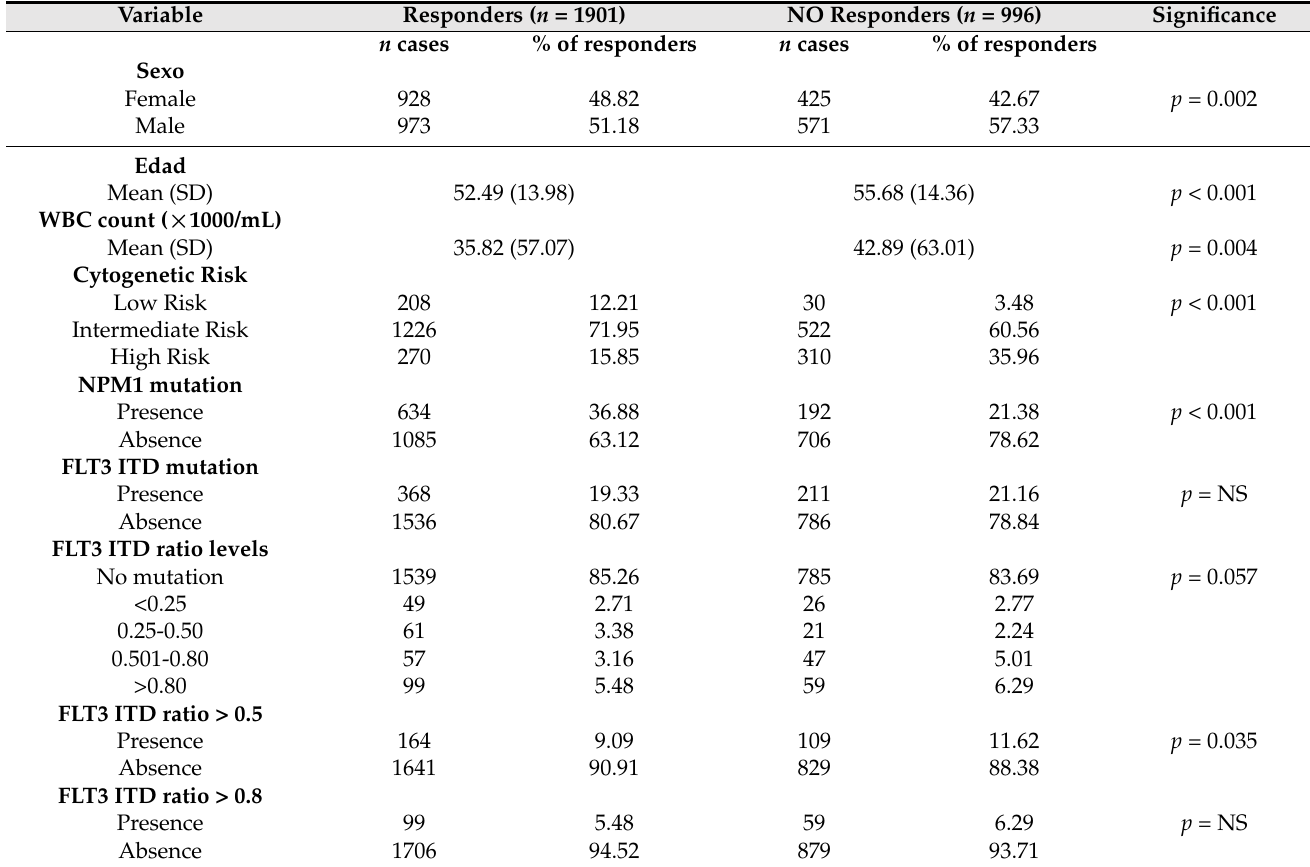
Table 2. Response to induction treatment. Patients who achieved CR/CRi from 1, 2, or 3 cycles of treatment induction were defined as responders. Abbreviations: WBC, white blood cell; cytogenetic risk based on MRC